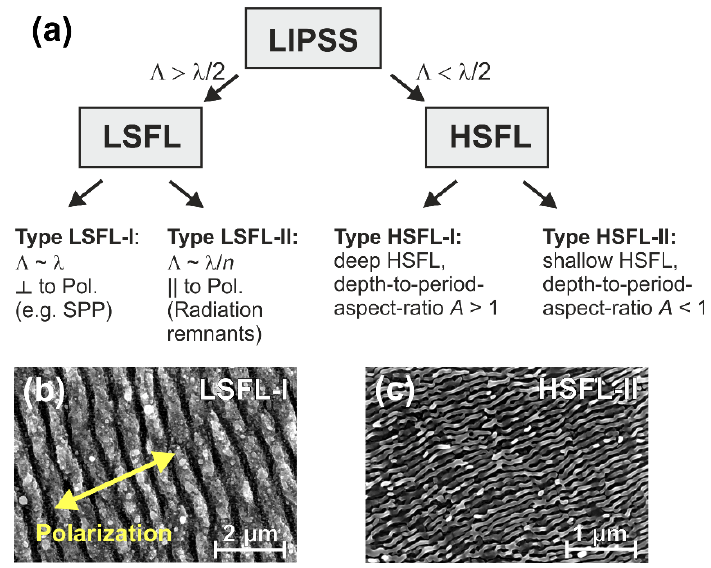
Figure 1. ( a ) General classification of laser-induced periodic surface structures (LIPSS) into different types of low spatial frequency LIPSS (LSFL) and high spatial frequency LIPSS (HSFL). © 2016 IEEE. Reprinted, with permission, from [1], Bonse, J.; Höhm, S.; Kirner, S.V.; Rosenfeld, A.; Krüger, J. Laser-induced periodic surface structures—A scientific evergreen, IEEE J. Sel. Top. Quantum Electron, 2017 , 23 , 9000615. SEM micrographs of near wavelength-sized LSFL-I ( b ) and sub-wavelength HSFL-II ( c ) on Ti6Al4V surfaces after irradiation with multiple fs-laser pulses in air (pulse duration τ = 30 fs, center wavelength λ = 790 nm, pulse repetition frequency 1 kHz). Note the different magnifications. The double arrows in ( b ) mark the direction of laser beam polarization. ( b , c ) are reproduced from Kirner et al. [9], Nanometer-resolved chemical analyses of femtosecond laser-induced periodic surface structures on titanium, J. Appl. Phys, 2017 , 122 , 104901, https://dx.doi.org/10.1063/1.4993128, with the permission of AIP Publishing.